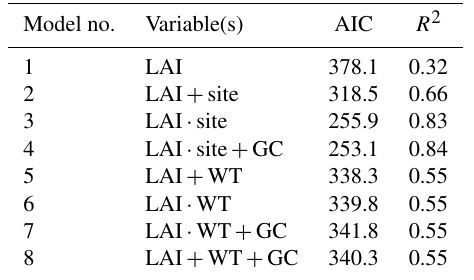
Table 2. Summary of generalized linear model (GLM) results for interception storage capacity ( β s ). LAI is leaf area index, GC is ground cover, and WT is water table (shallow versus deep). The best model needs to be noted in BOLD (Model no.